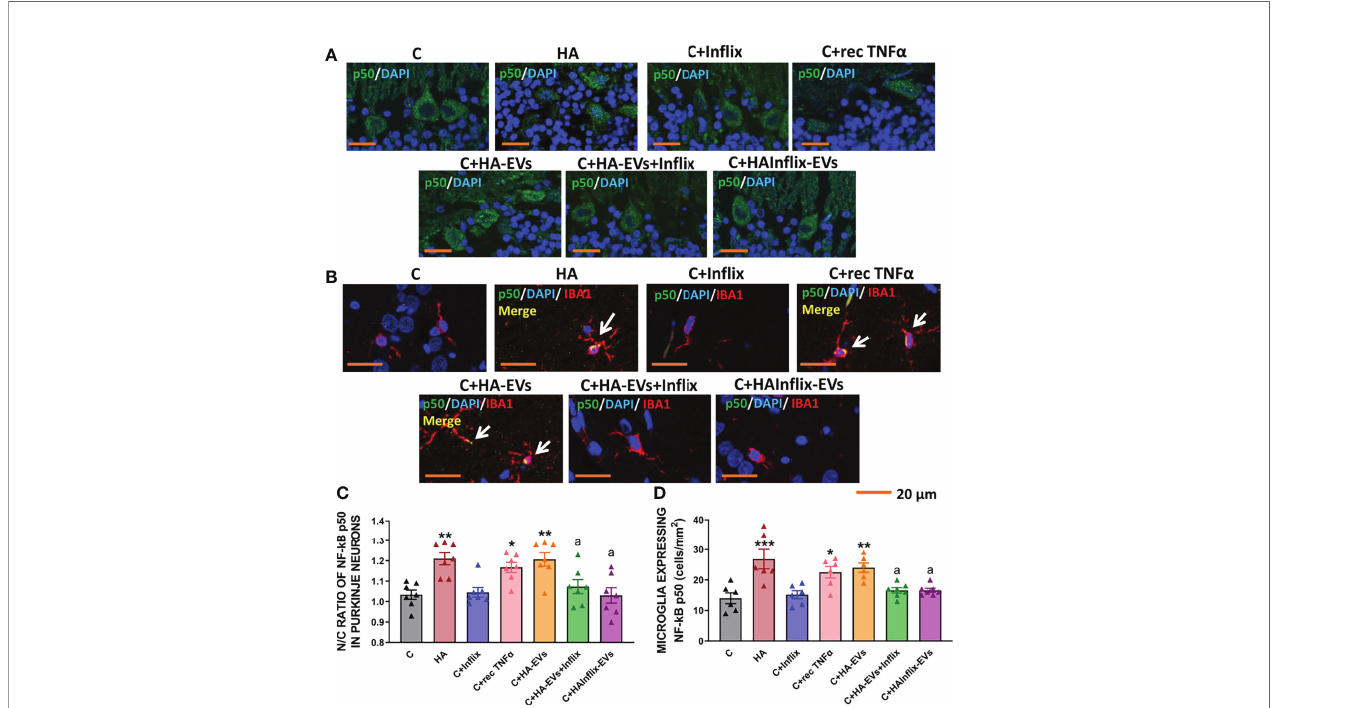
FIGURE 4 | Extracellular vesicles from hyperammonemic rats induce NF- k B activation in Purkinje neurons and microglia in cerebellar slices from control rats. Representative images of (A) immuno fl uorescence against NF- k B p50 subunit (green) and (B) double immuno fl uorescence against NF- k B p50 subunit (green) and Iba1 (red). (C) Ratio of Nuclear/Cytoplasmic NF- k B p50 subunit in Purkinje neurons (n=6-7). (D) Number of microglial cells expressing NF- k B p50 subunit in white matter of the cerebellum, measured by double immuno fl uorescence and expressed as cells/mm 2 (n=7). Sample size indicates number of animals. One-way ANOVA with Tukey post-hoc test was performed to compare all groups. Values are the mean±SEM. Values signi fi cantly different from controls are indicated by asterisk (*p<0.05, **p<0.01, ***p<0.001) and values signi fi cantly different from C+HA-EVs group are indicated by a (a=p<0.05). Scale bar = 20 m